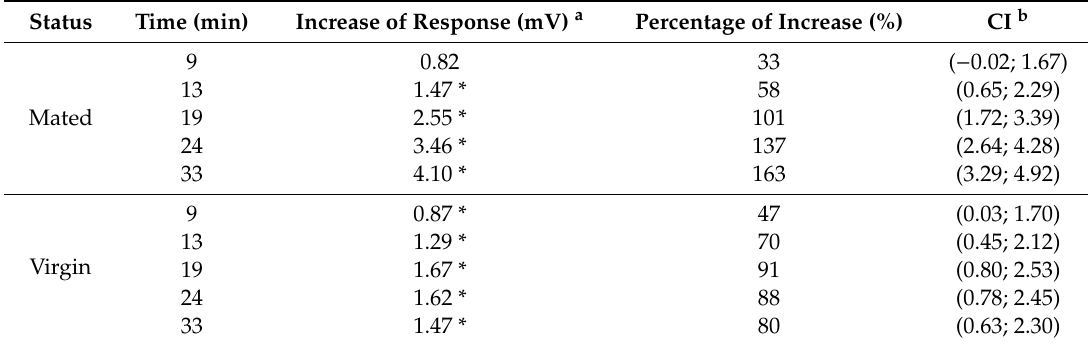
Table 1. Increase of the mean response to 1 µg of TDTA in virgin and mated T. absoluta males when stimulated at different times relative to that at T = 0 min.